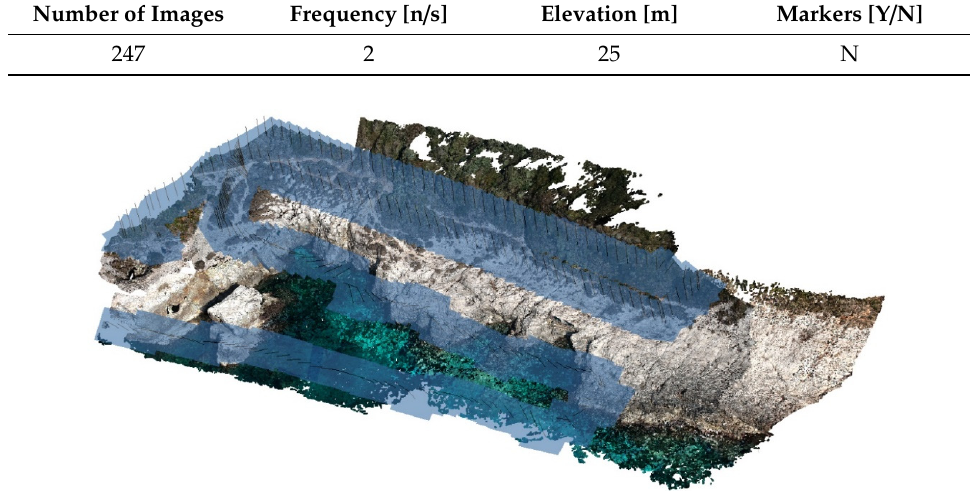
Table 4. Acquisition parameters with UAV at Premantura (Croatia).